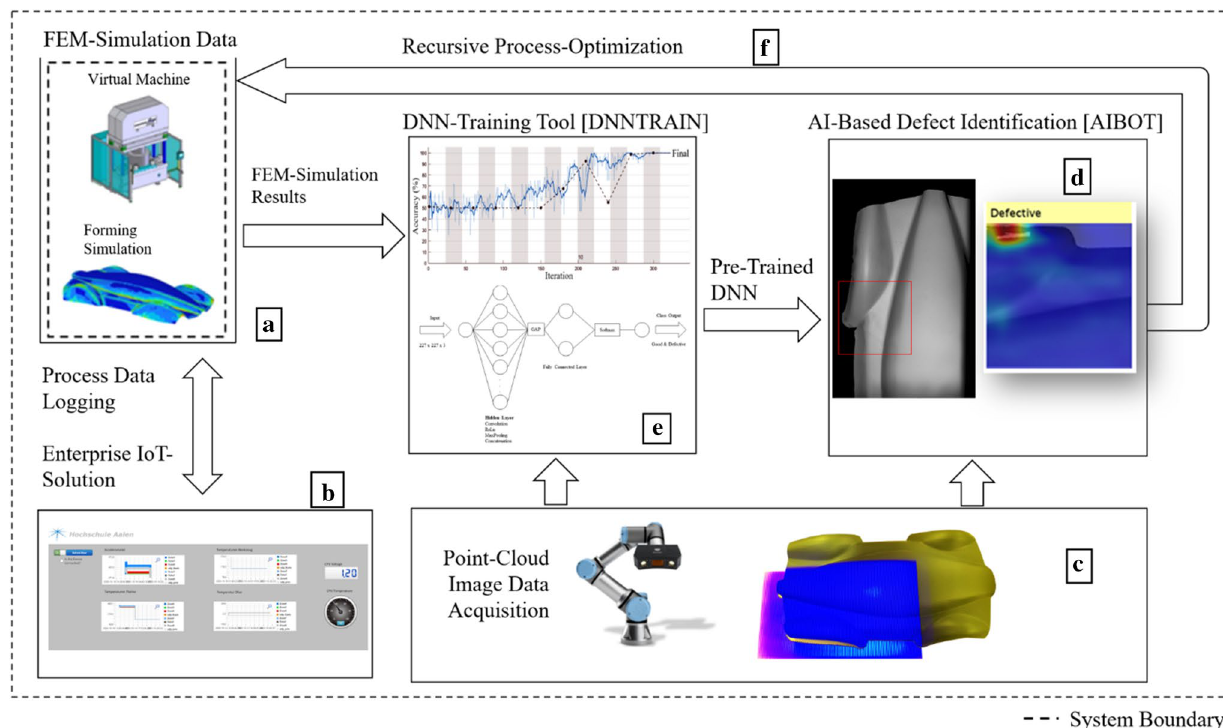
Fig. 1 Simulation based recursive DNN training data generation of the forming